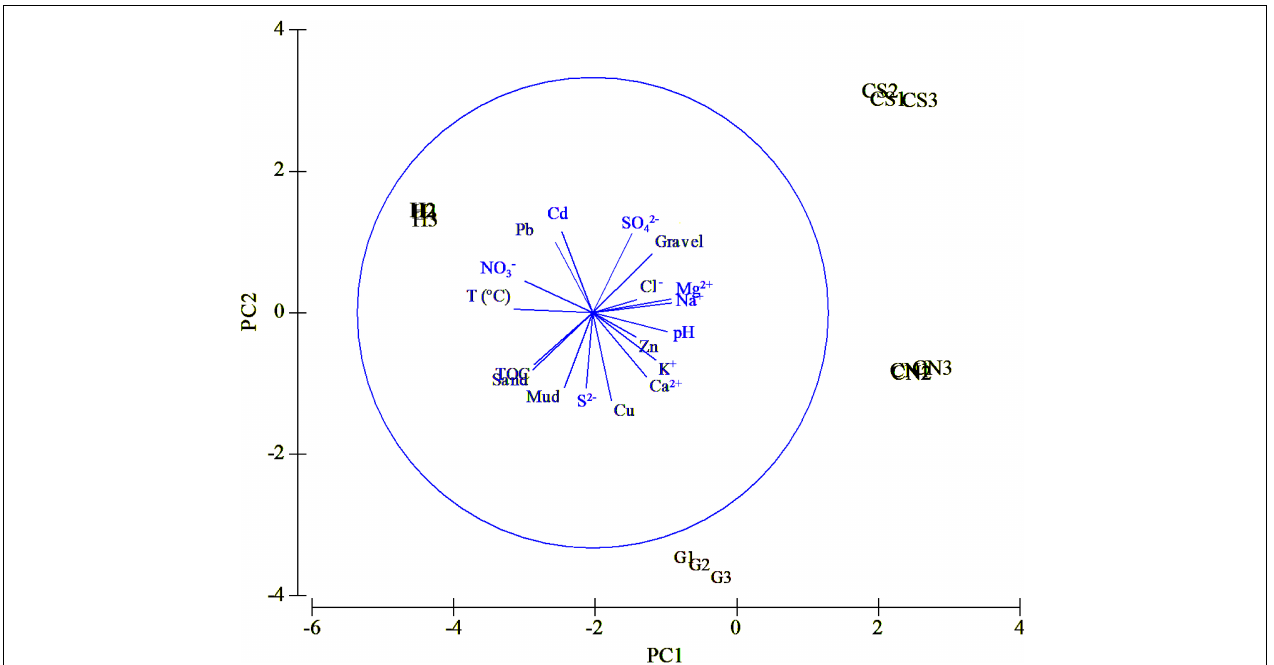
FIGURE 4 | Ordination of environmental variables at the four sites of the Secca delle Fumose using